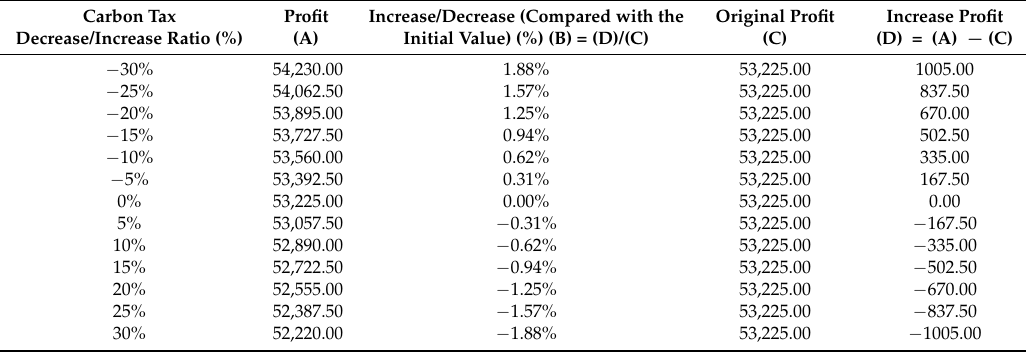
Table 5. Sensitivity analysis on the carbon tax of model 1.